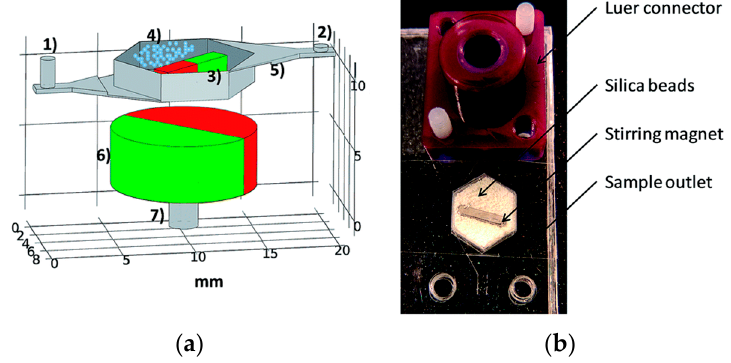
Figure 7. Miniaturized bead beading cell lysis system: ( a ) various components: (1) inlet; (2) outlet; (3) stirring magnet; (4) zirconia/silica beads; (5) bead weir; (6) rotating magnet; and (7) electric motor coupling; and ( b ) image of the device for lysis. Reproduced with permission from [50].